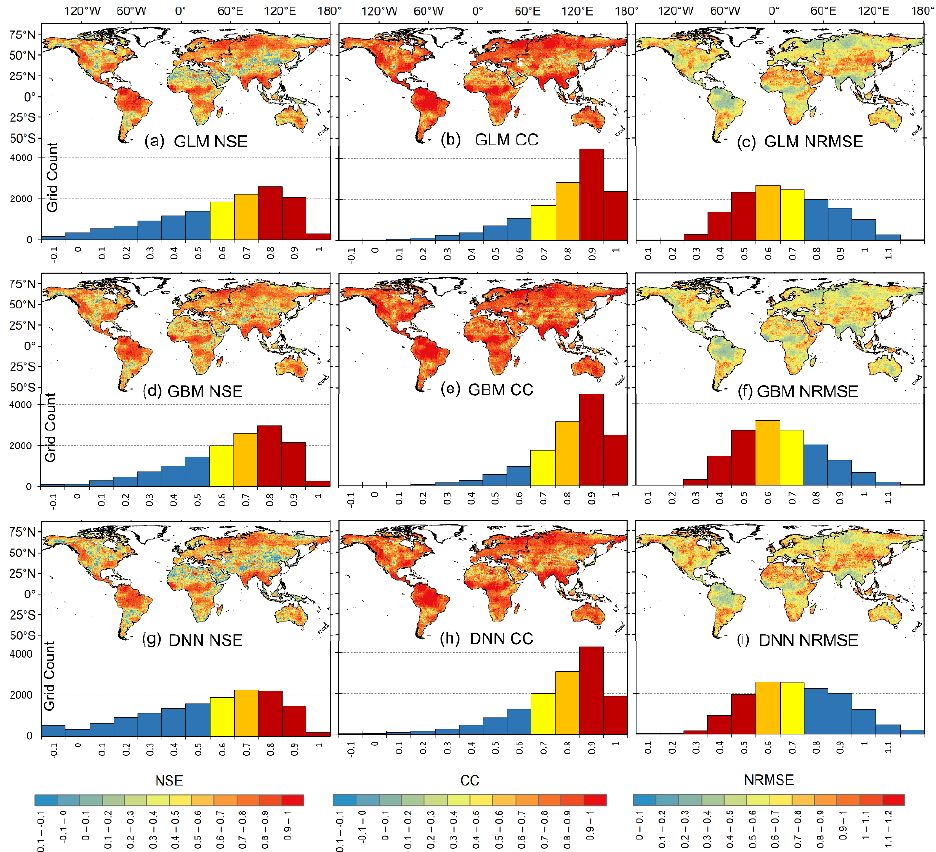
Figure 3. Spatial (maps) and frequency (bar plots) distributions of the grid-scale testing perfor- mance for the ( a – c ) GLMs, ( d – f ) GBM models, and ( g – i ) DNN models. The color-coded frequency distribution shows the very good (red), good (orange), satisfactory (yellow), and poor (blue) perfor- mance